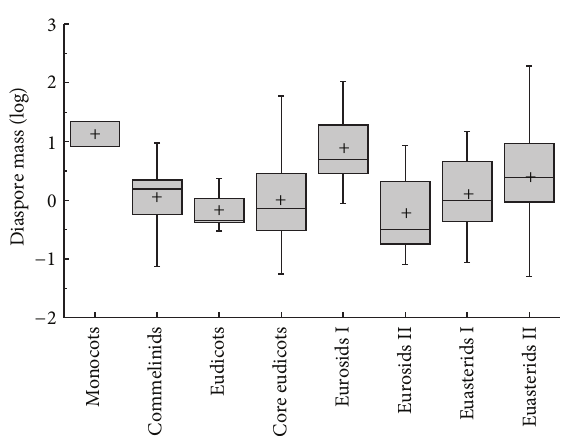
Figure 3: Box plots showing mean (+), median (—), quartiles, and outliers (-) of diaspore mass of 150 species grouped by different dispersal syndromes.